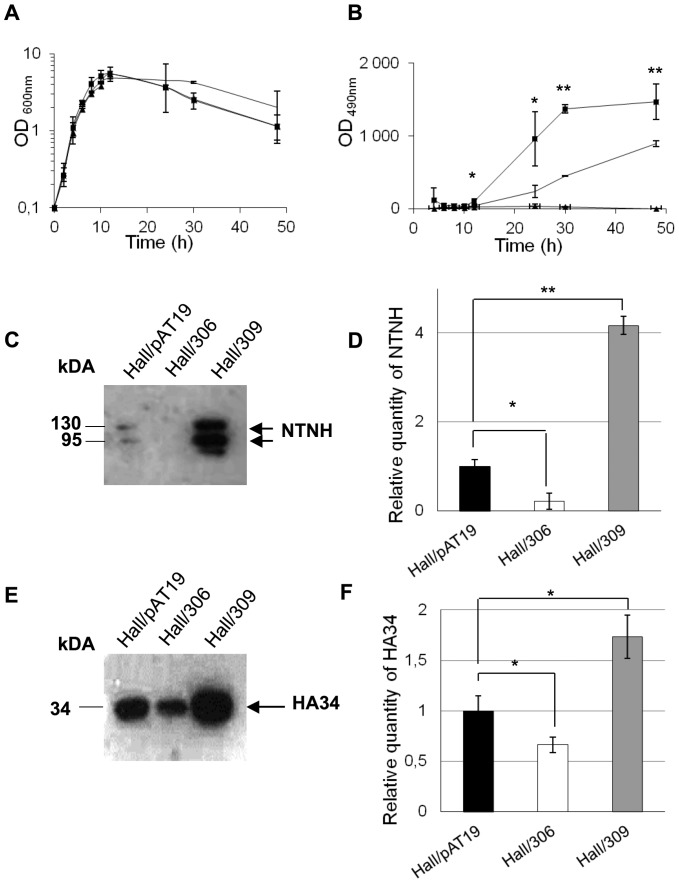
Growth kinetics, BoNT/A, NTNH, and HA34 production in Hall botR/A isogenic antisense strains.(A) Growth curves of Hall/pAT19 (empty vector), Hall/306 (antisense botR/A mRNA), and Hall/309 (botR/A overexpression) were determined by measurement of optical density at 600 nm (OD600). (B) BoNT/A was assayed in the culture supernatants by ELISA and expressed as OD at 490 nm. Production of NTNH (C) and HA34 (E) were determined in the supernatant of 12 h cultures by Western blotting with specific antibodies and quantification with ImageJ (D, F) (means +/− SD; n = 3), *P<0.05 and **P<0.005. Note that western blotting with anti-NTNH antibodies show native (130 kDa) and partially processed NTNH in its 115 kDa fragment.